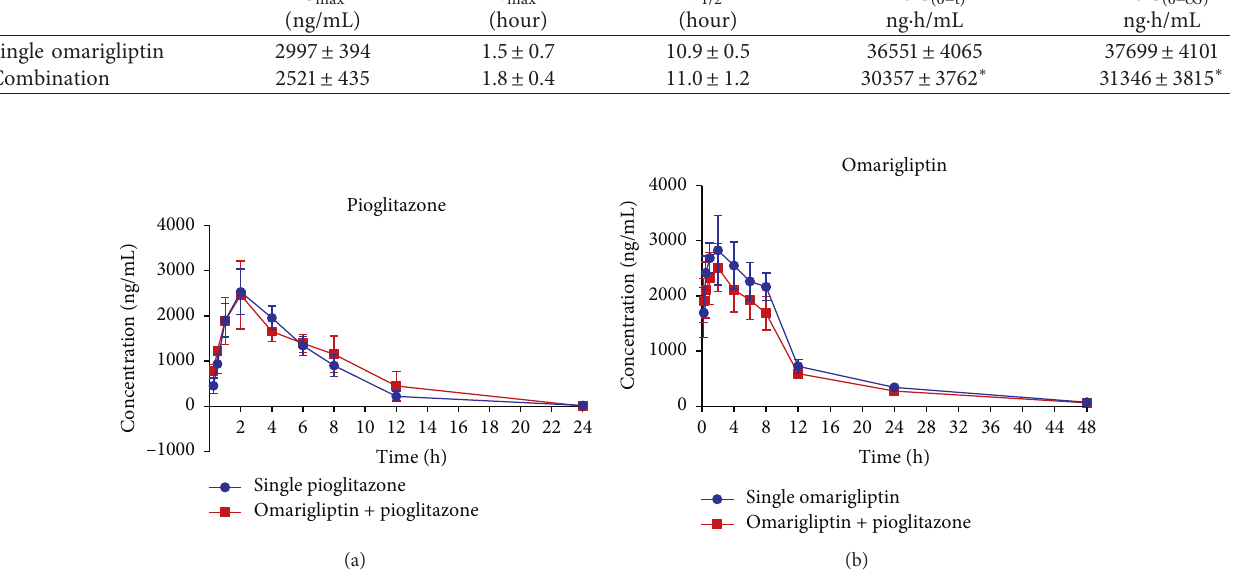
Figure 5: Mean plasma concentration-time curves after oral administration of pioglitazone (2.6mg/kg), omarigliptin (2.6mg/kg), or pioglitazone (2.6mg/kg) plus omarigliptin (2.6mg/kg) (mean ± SD, n �